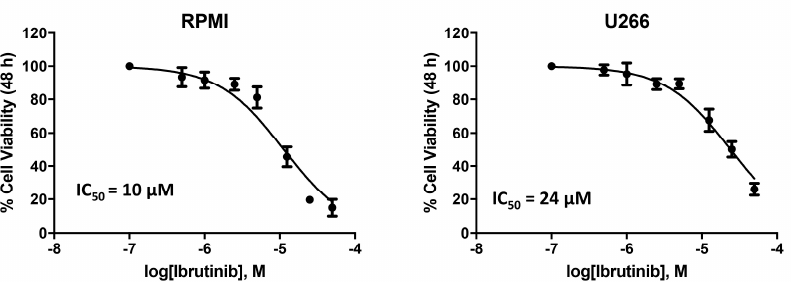
Figure 1. Ibrutinib treatment reduces cell viability in RPMI and U266 cell lines. Cell viability was evaluated by MTT in MM cells treated with Ibrutinib at different doses for 48 h.